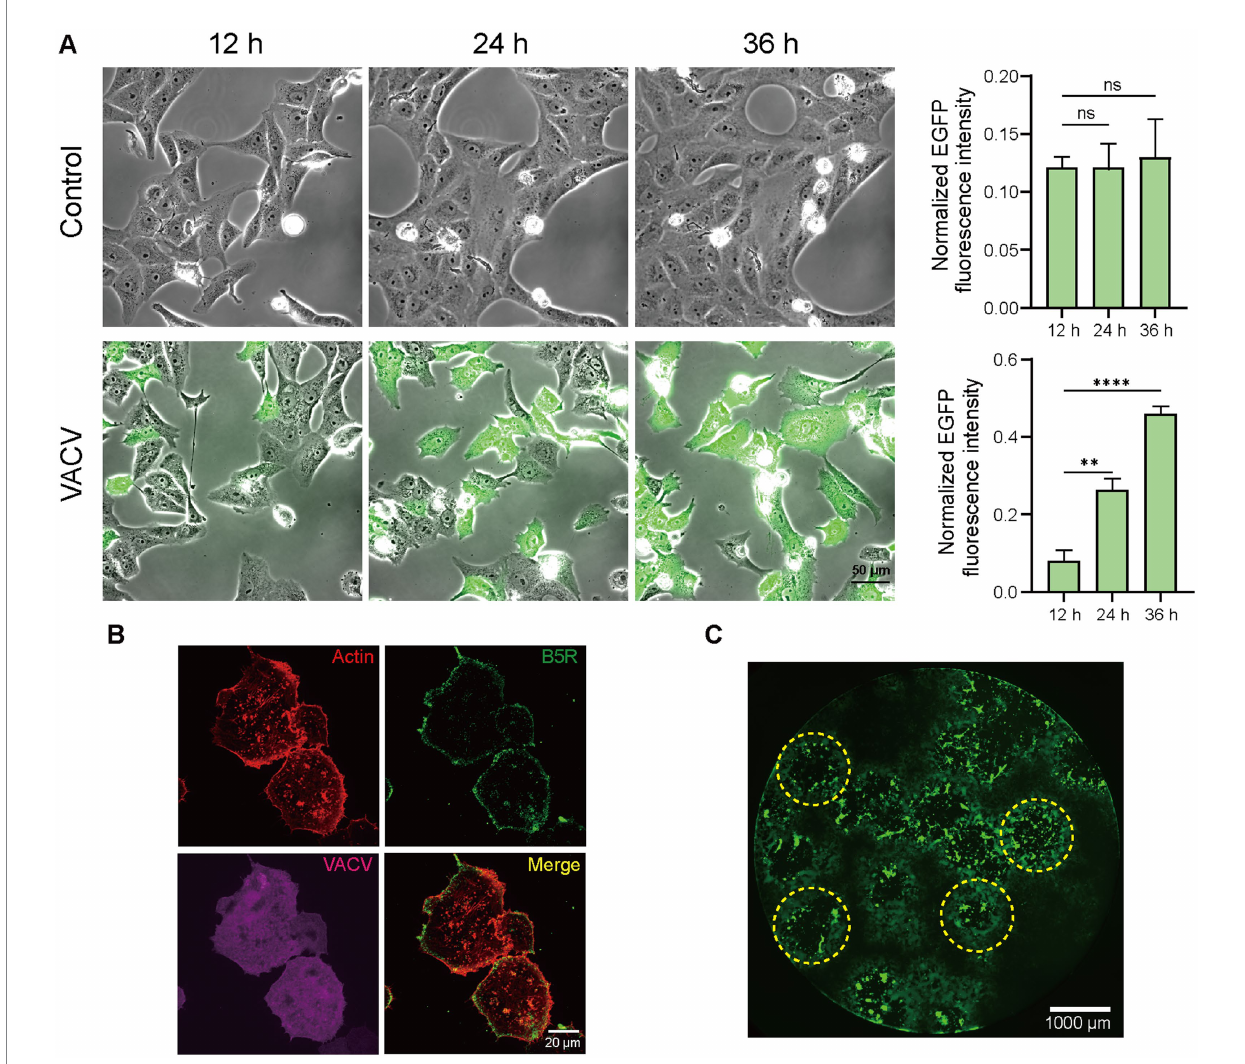
FIGURE 2 High-resolution live-cell images of VACV-infected host cells. (A) Representative images and normalized fluorescent quantitative analysis of non- infected and VACV-infected Vero cells (EGFP label) at 12, 24, and 36 h.p.i. Scale bar represents 50 μ m. Data are mean ± SEM. * p < 0.05, ** p < 0.01, and *** p < 0.001 (unpaired t -test); ns, not statistically significant. (B) Representative fluorescence images of VACV-infected cells containing actin tails (Actin: red; B5R: green; VACV: magenta). Scale bar represents 20 μ m. (C) Representative fluorescence images of virus plaques (yellow dotted circles) at VACV 48 h.p.i. Scale bar represents 1,000 μ